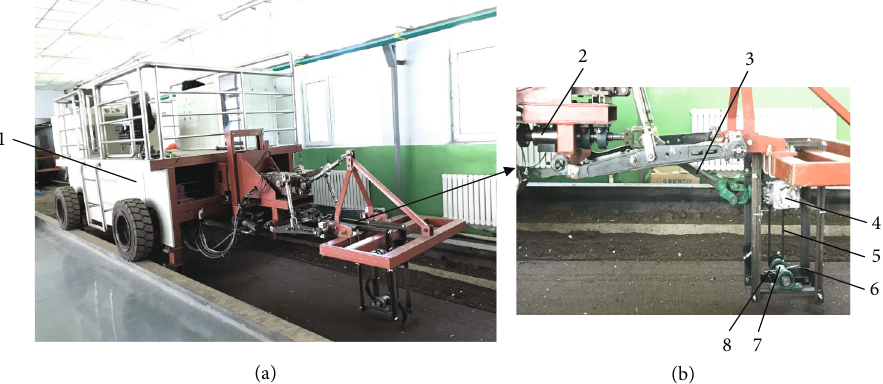
Figure 6: Soil bin tests: (a) soil bin and test equipment and (b) test toolbar: 1: soil bin trolley; 2: torque sensor; 3: universal joint coupling; 4: gear box; 5: synchronous belt wheel; 6: rotary tillage blade; 7: rotary shaft; 8: blade